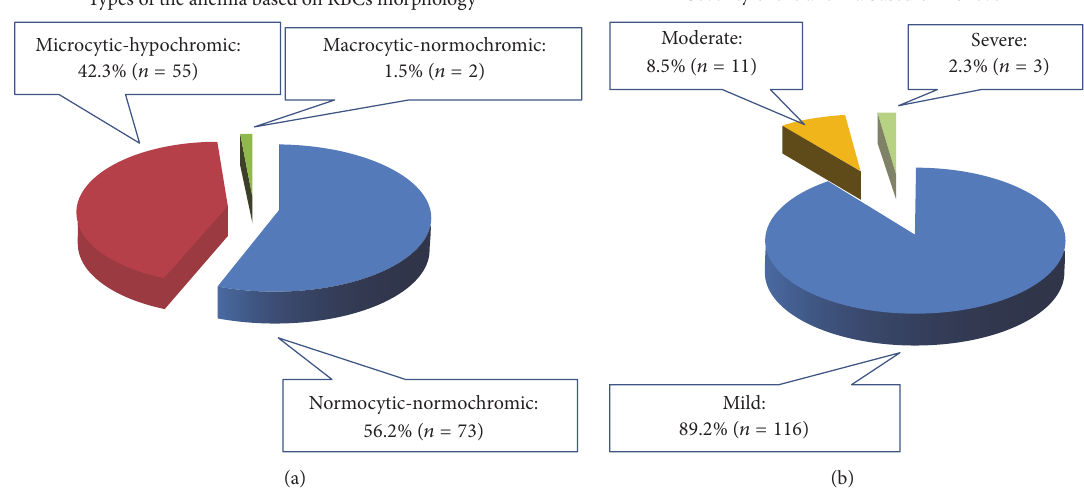
Figure 2: Morphological classification (a) and severity (b) of anemia among anemic pregnant women attending ANC clinic at Pugnido ARRA Health Center in Gambela, Western Ethiopia, April 15–June 30/2015 ( 𝑛 = 130 ). Mild anemia : hemoglobin concentration between 10g/dL and 10.9 g/dL; moderate anemia : hemoglobin concentration between 7g/dL and 9.9 g/dL; severe anemia : hemoglobin concentration less than 7g/dL; normocytic-normochromic anemia : hemoglobin concentration less than 11g/dL, MCV value between 80 fL and 100fL and MCHC value between 32 g/dL and 36 g/dL; microcytic-hypochromic anemia : hemoglobin concentration less than 11g/dL, MCV value less than 80 fL and MCHC value less than 32 g/dL; macrocytic : MCV value greater than 100 fL.